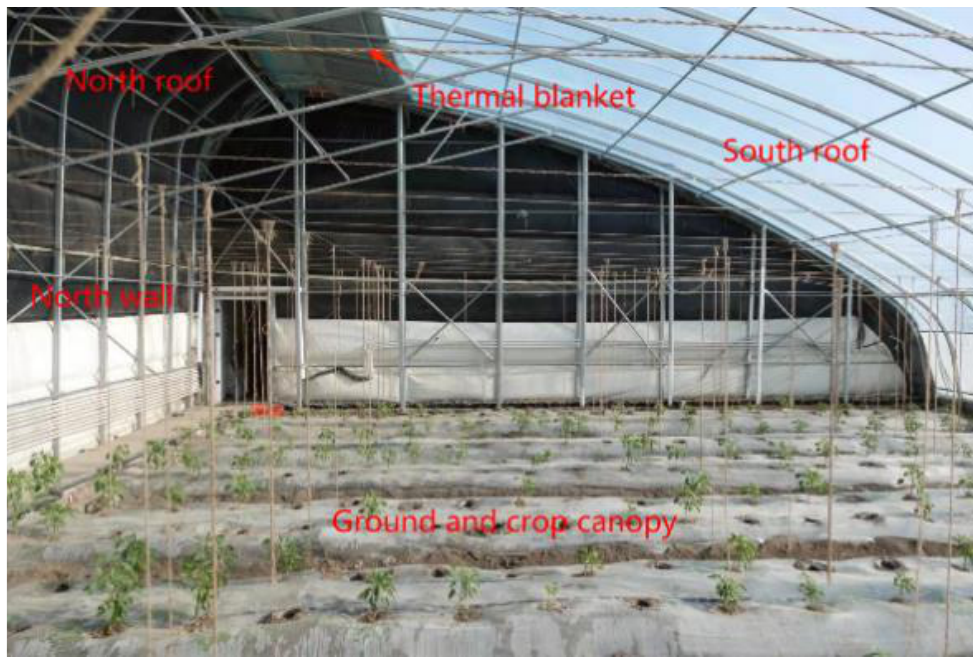
Figure 2. Internal views of CSG.